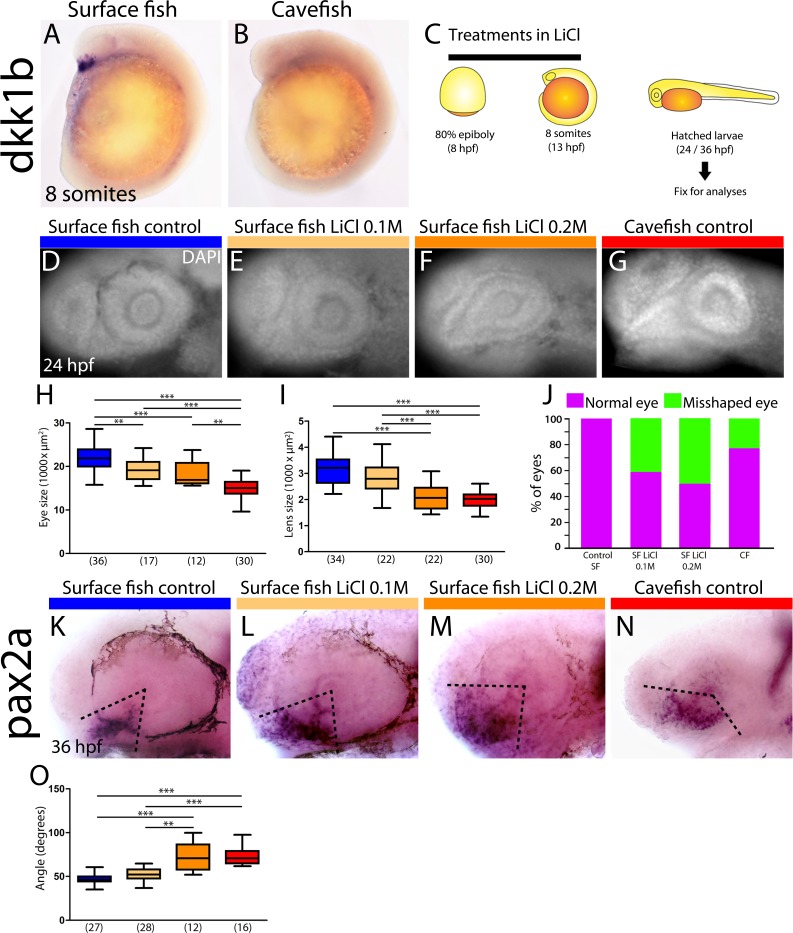
Differential off-set of dkk1b expression may be relevant for the optic phenotype in cavefish.(A, B) Expression of dkk1b at the 8-somite stage in surface fish (A) and cavefish (B). (C) Experimental design for LiCl treatments. Dechorionated surface fish embryos were treated in LiCl solutions from the end of gastrulation (8 hpf, left) until mid-somitogenesis (13 hpf, center) and then fixed for analyses at larvae stages (24 or 36 hpf, right). (D–J) Effect of LiCl treatments analyzed at 24 hpf. Surface fish untreated (D), treated with 0.1M and 0.2M LiCl (E and F, respectively) and cavefish untreated (G), stained with DAPI at 24 hpf. Quantification of the eye size (H) lens size (I) and percentage of embryos with misshaped developing eye (J). (K–O) Effect of LiCl treatments analyzed at 36 hpf. Expression of pax2a at 36 hpf in the optic stalk/optic fissure of surface fish that were untreated (K) or treated with0.1M and 0.2M LiCl (L and M, respectively) and of untreated cavefish (N). (O) Quantification of the measured angle (indicated in K-N as black dashed lines). Kruskal-Wallis tests with Dunn’s post-test, were performed. **, p = <0.01; ***, p = <0.001.